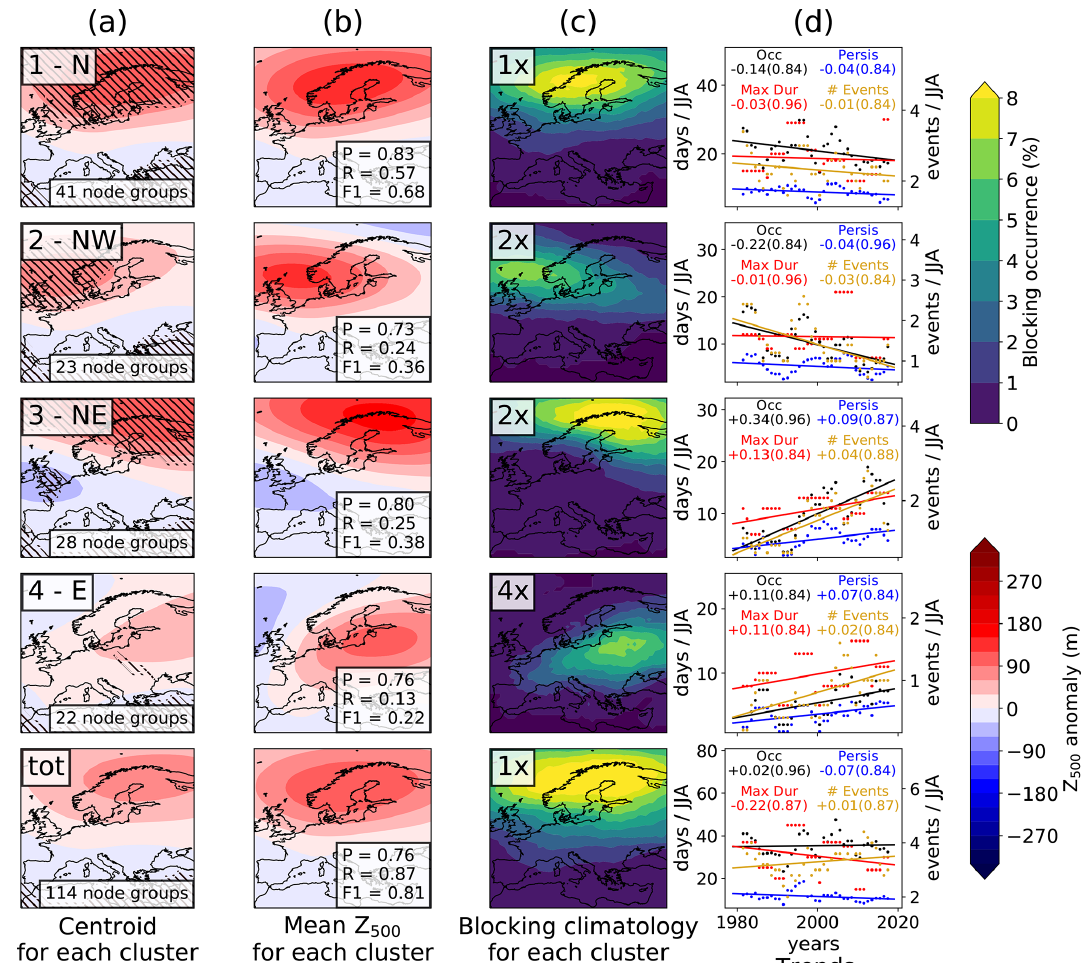
Figure 11. Application of the SOM-BI to ERA5 Z 500 1979–2019 JJA, using the method outlined in Sect. 2.7. (a) The K -means centroids of the mean codebooks. Hatching indicates regions where the mean codebooks for contributing node groups agree on the sign. The number of node groups associated with each cluster is indicated in the bottom right of each panel. The labels in the top right of each panel reflect the main region with a positive anomaly. “tot” is the total combination across all blocked node groups. To show that the four clusters are consistent with the fields they represent, we show in column (b) the average Z 500 field across all days belonging to each cluster of blocked node groups. At the bottom right of each panel in column (b) the precision, recall and F1 scores are shown for each cluster. (c) The blocking climatology for each set of node groups, derived using the DG83 index for each blocked day identified by SOM-BI for the given K -means cluster. Since the frequency of blocked events varies strongly between each cluster, the climatologies have been scaled by the numbers in the top left of each panel. (d) Historical trends as characterized by four different metrics for each cluster, using 5-year moving average data: black – occurrence of pattern; blue – persistence (average duration) of pattern; red – maximum duration of block; gold – average number of blocked events (uses the right hand y -axis scale). The numbers (numbers in brackets) show the gradients ( p values) for each trend, which are all insignificant after correcting for multiple testing and